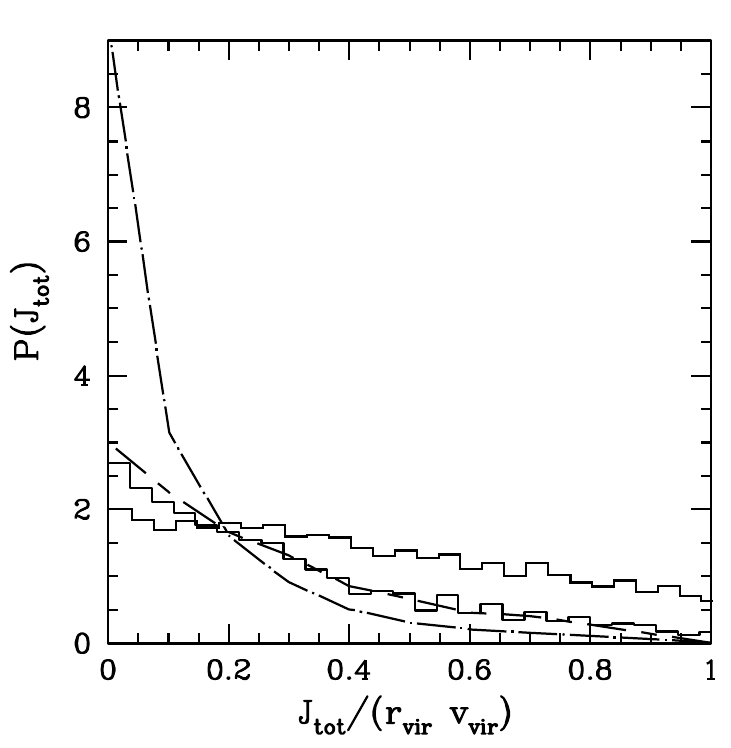
Fig. 1. Distribution of the total speci(cid:12)c angular momentum, J tot . The dotted-dashed and dashed lines represent the quoted distribution for the van den Bosch et al. (2002) halo versions 170 and 081, respectively. The upper histogram is the distribution obtained from our model for the 10 12 M ⊙ halo and the bottom histogram is the angular momentum distribution for the density pro(cid:12)le reproducing the NFW halo, as descried in the